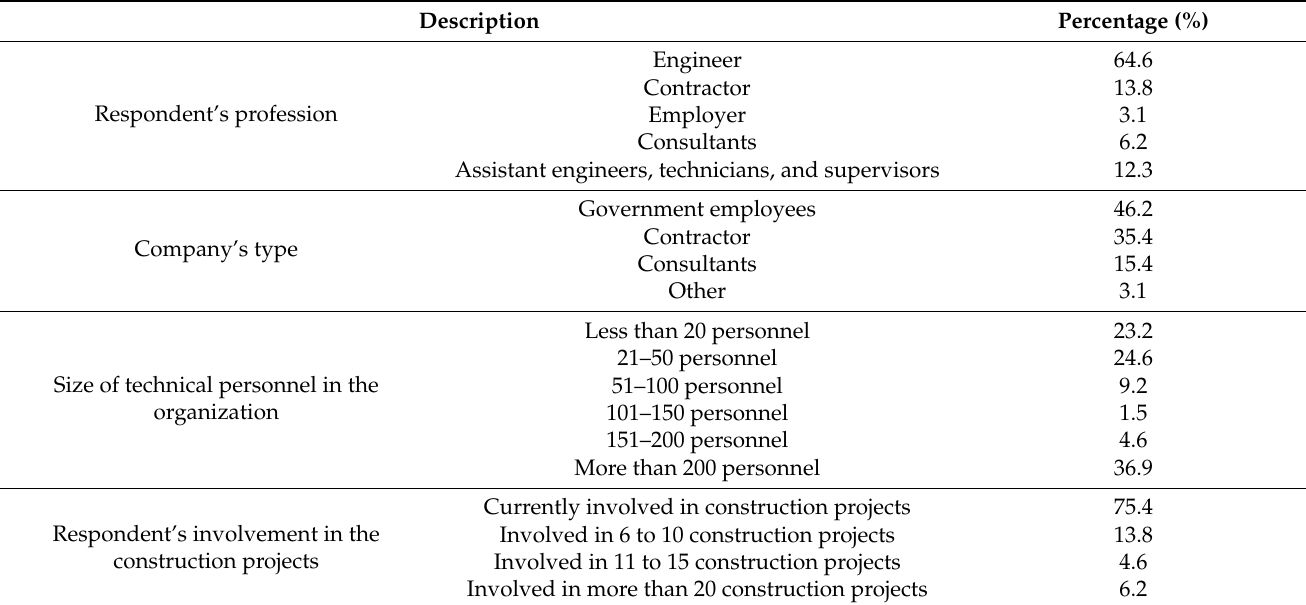
Table 1. Demographic information of the respondents.